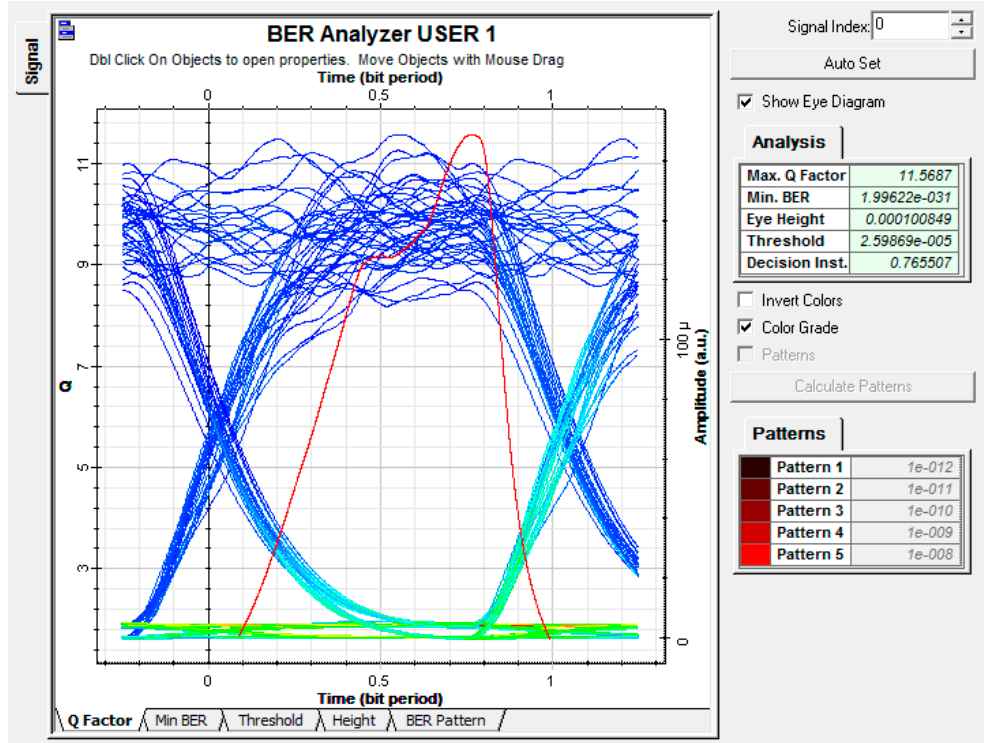
Photonics 2022 , 9 , 310 Figure 17. Diagram of the first user’s eye at 1 Gbps. Figure 17. Diagram of the first user’s eye at 1 Gbps.